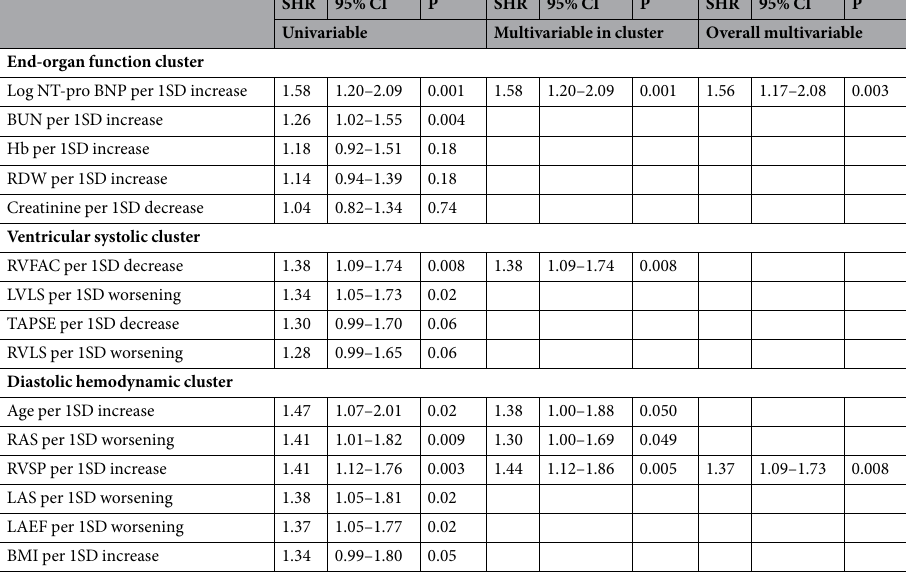
Table 3. Parameters are listed in descending order of standard hazard ratio within each cluster. If the number of parameters in the cluster is more than 6, only 6 parameters with higher standardized hazard ratio were listed in the Table. The parameters in the other clusters were not listed because all of the parameters were not significantly associated with the outcome. BMI; body mass index, LAS; left atrial strain, LAVI; left atrial volume index, LVLS; left ventricular longitudinal strain, NT-proBNP; N-terminal pro B-type natriuretic peptide, RAS; right atrial strain, RDW; red cell distribution width, RVFAC; right ventricular fractional area change, RVLS; right ventricular longitudinal strain, RVSP; right ventricular systolic pressure, SHR; standardized hazard ratio, TAPSE; tricuspid annular plane systolic